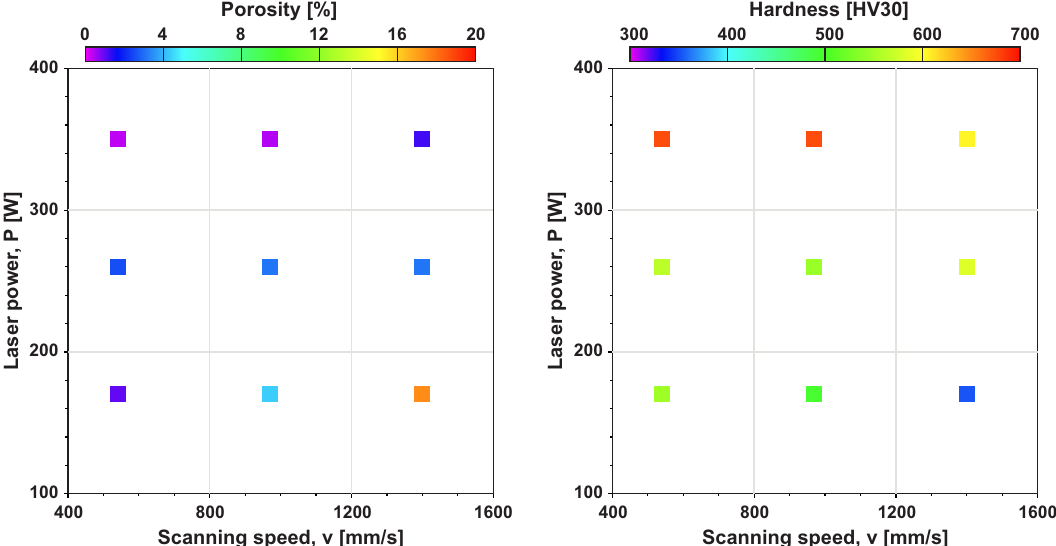
Figure 11. Data of porosity and hardness displayed in P-v space.